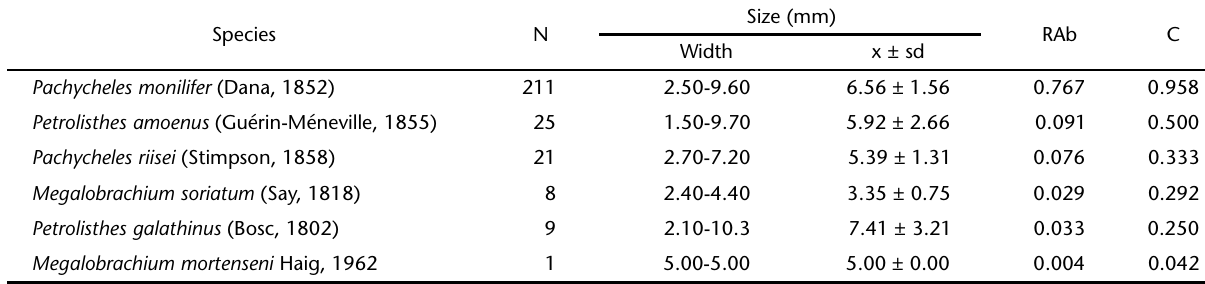
Table I. Porcellanid species collected from February 2004 through January 2006 off Vitória Island. Absolute abundance (N); range and mean size of the carapace width; relative abundance (RAb); and the constancy index (C) are presented. Species